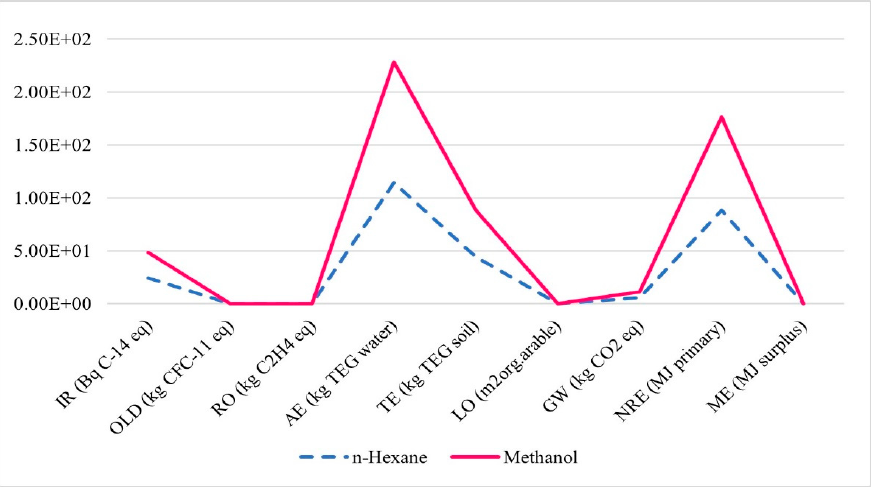
Figure 8. Environmental impact categories for different types of solvents in the fat extraction